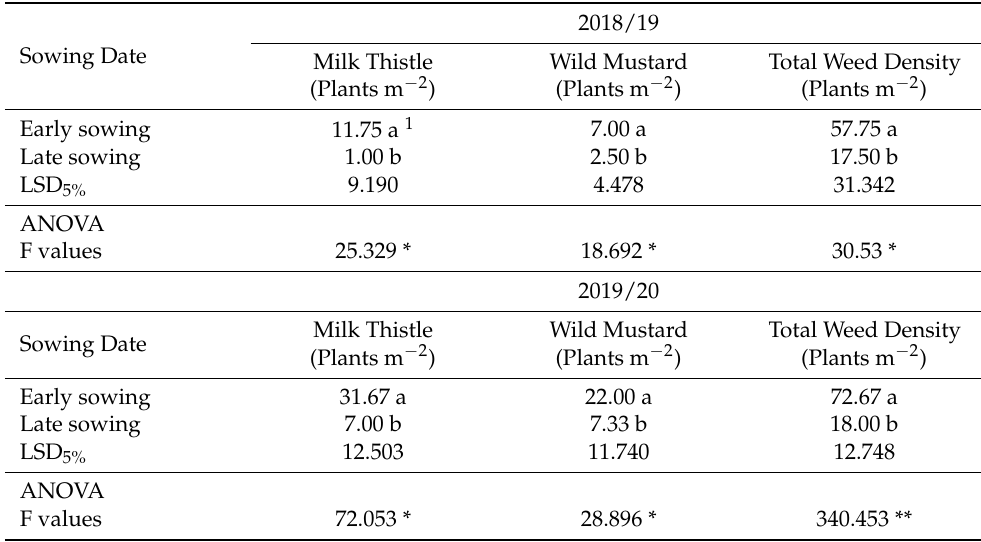
Table 3. Milk thistle, wild mustard, and total weed density as affected by the sowing date (early and late